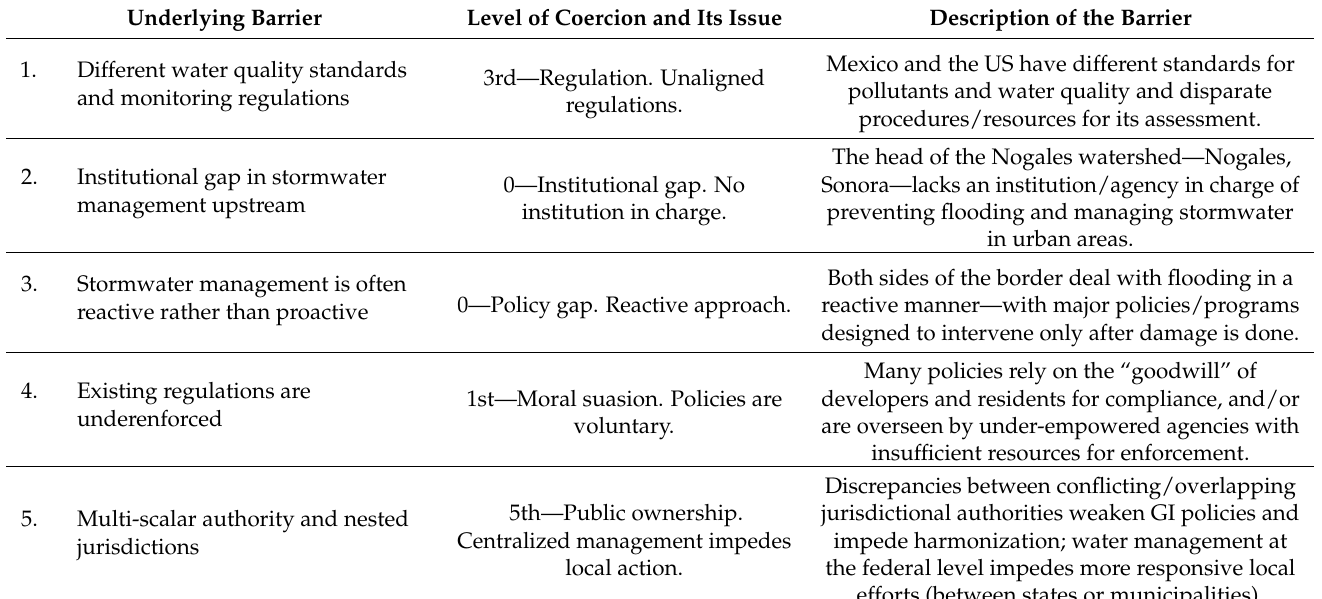
Table 4. Summary of policy-related barriers for GI adoption and